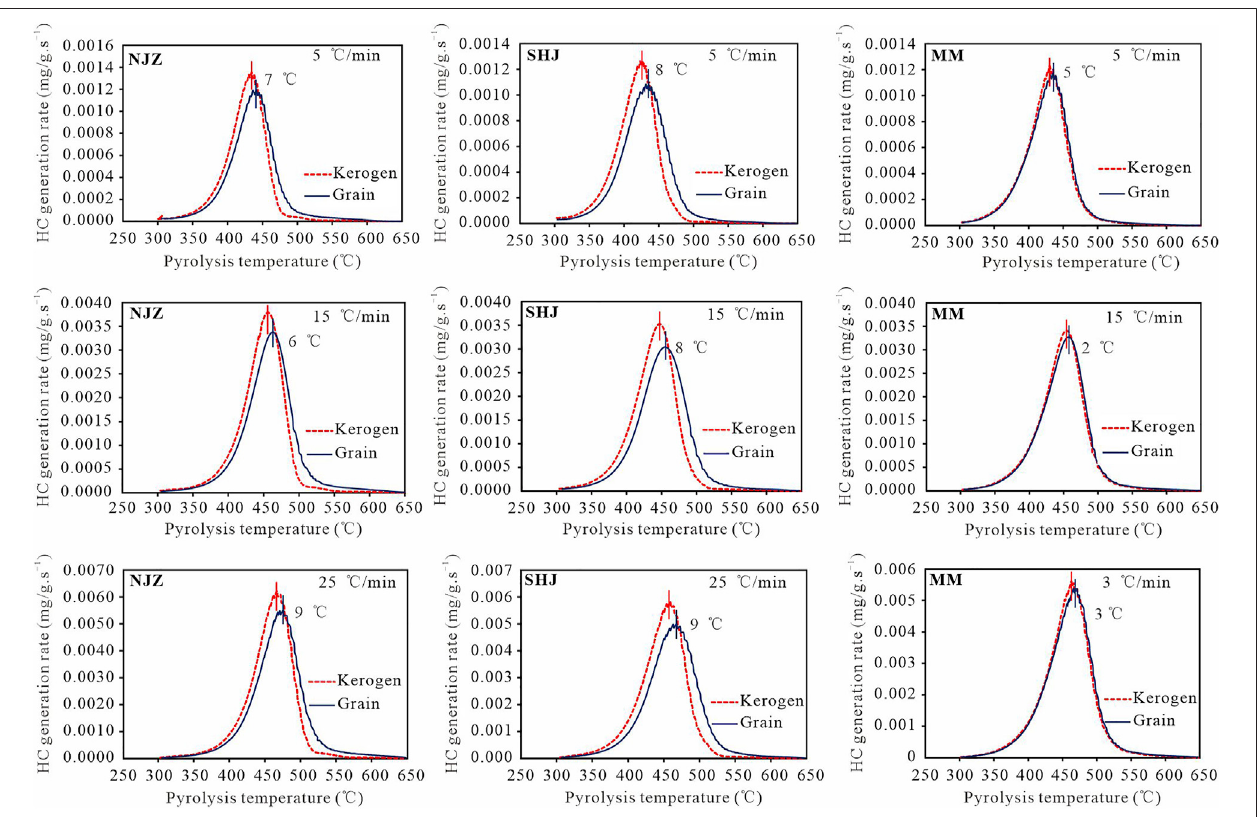
FIGURE 5 | Hydrocarbon (HC)-generating rate of grain and kerogen for NJZ shale, SHJ shale, and MM oil shale at the heating rates of 5 ° C/min, 15 ° C/min, and 25 ° C/min.